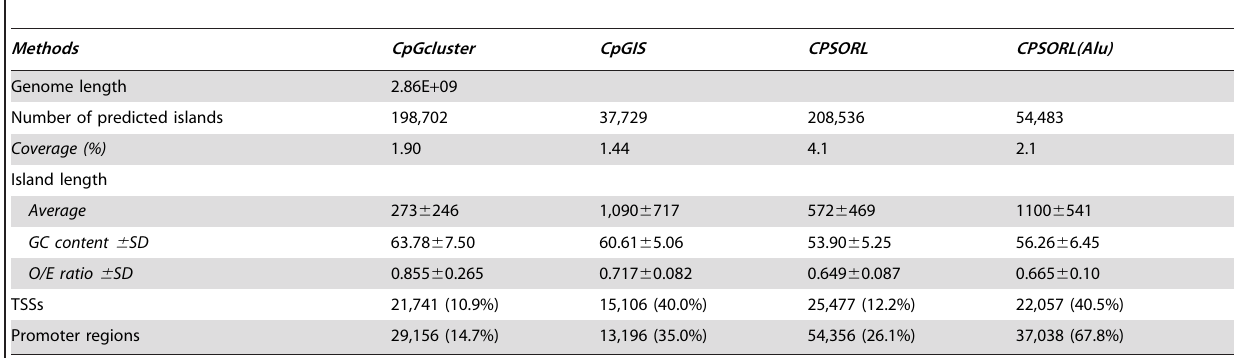
Table 6. Comparison of different methods on the number of CpG islands identified in the entire human genomes.